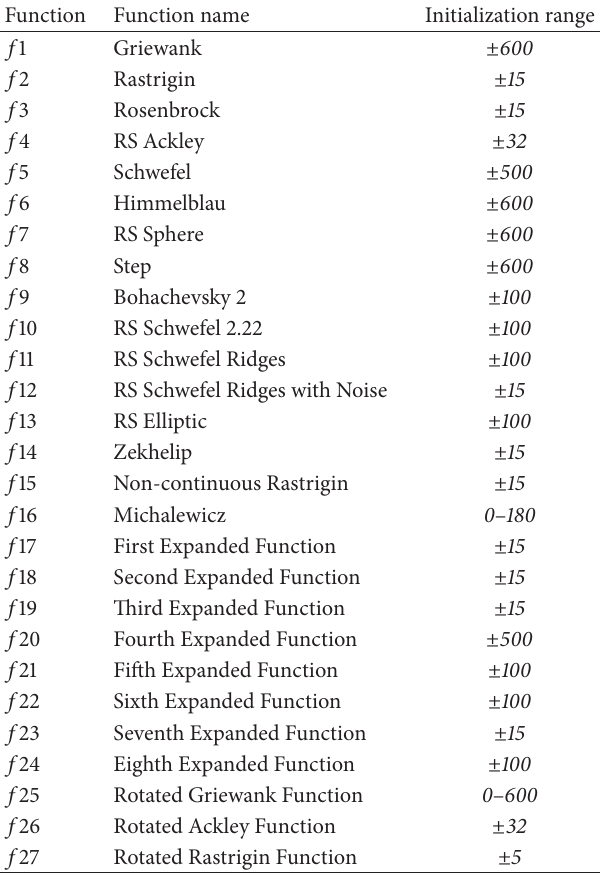
Table 1: Benchmark